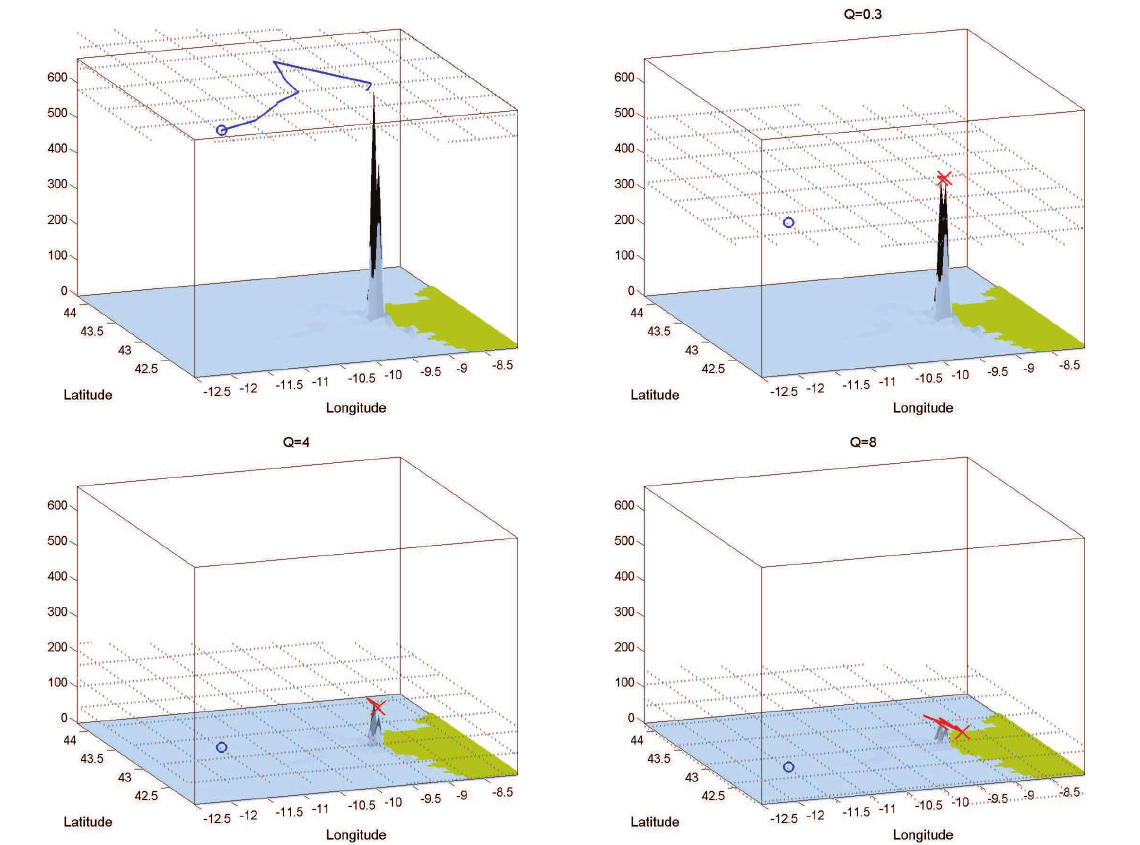
Fig. 8 3D view of the distribution c w , defined in Section 3.2.2, on 19 November 2002 for the experiments: ( Top-Left ) no pumping process, ( Top-Right ) OPT-0.3- (4), ( Bottom-Left ) OPT-4- (4) and ( Bottom Right ) OPT-8- (4). A plane at the same height as the maximum value of the oil concentration is also presented. In this plane the skimmer ship trajectory (continuous red line), the Prestige ship trajectory with no pumping process (continuous blue line), final position of the skimmer ship (x) and final position of the Prestige ship (o) are